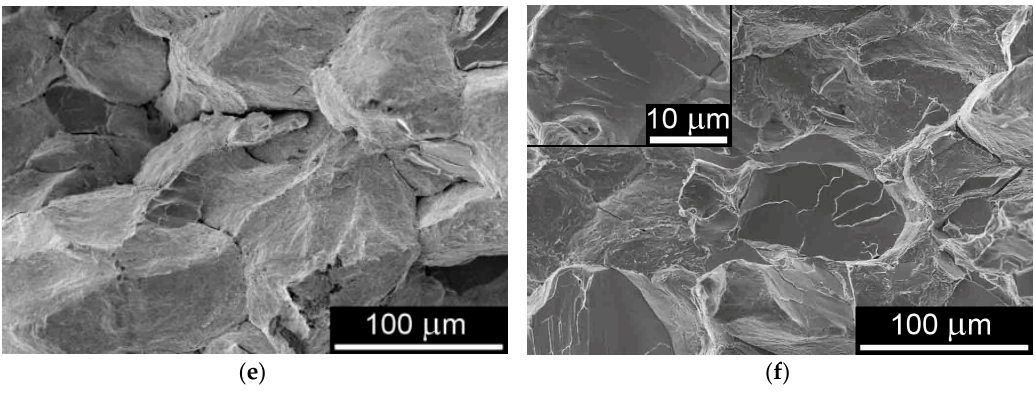
Figure 6. Microstructure of materials prepared from Zn150 powder, SEM : ( a ) 200 MPa, CP; ( b ) 500 MPa, CP; ( c ) 100 MPa, CP-S; ( d ) 500 MPa, CP-S; ( e ) 100 MPa, HP; ( f ) 500 MPa, HP.